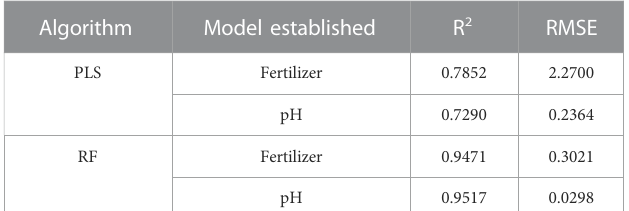
TABLE 2 Prediction results of two algorithm